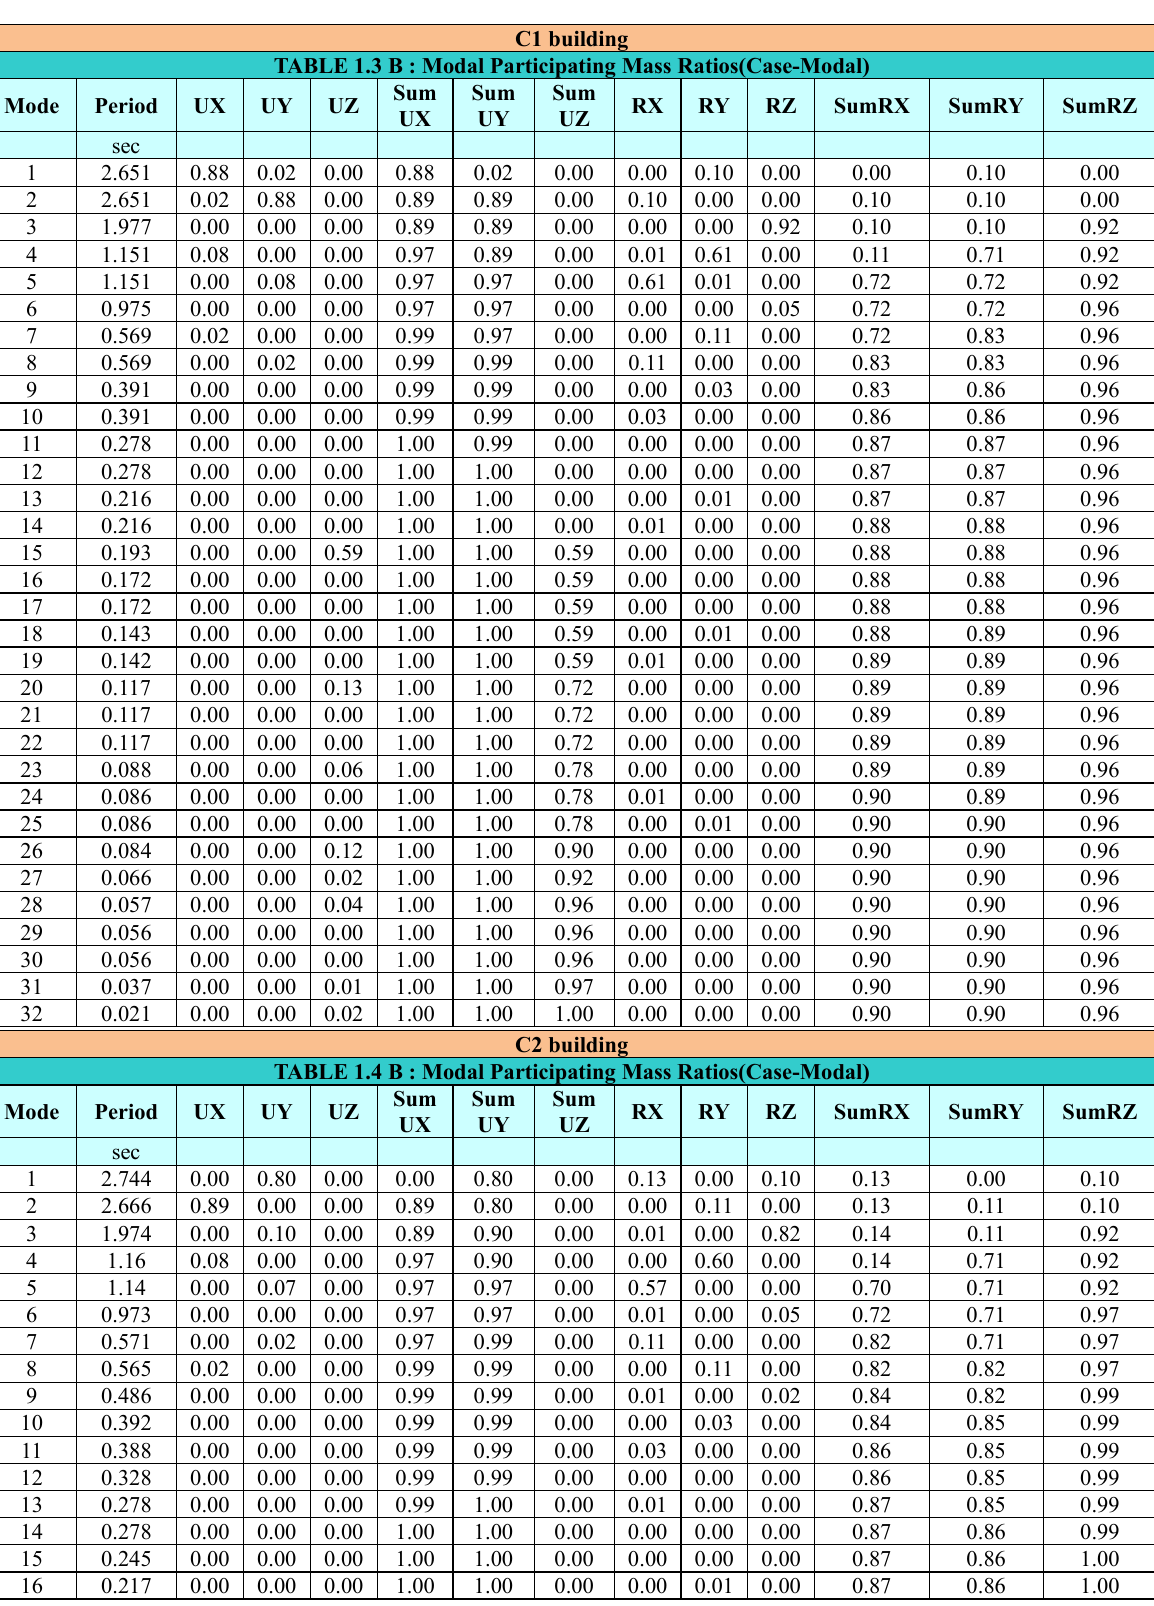
TABLE 1.3 B : Modal Participating Mass Ratios(Case-Modal)